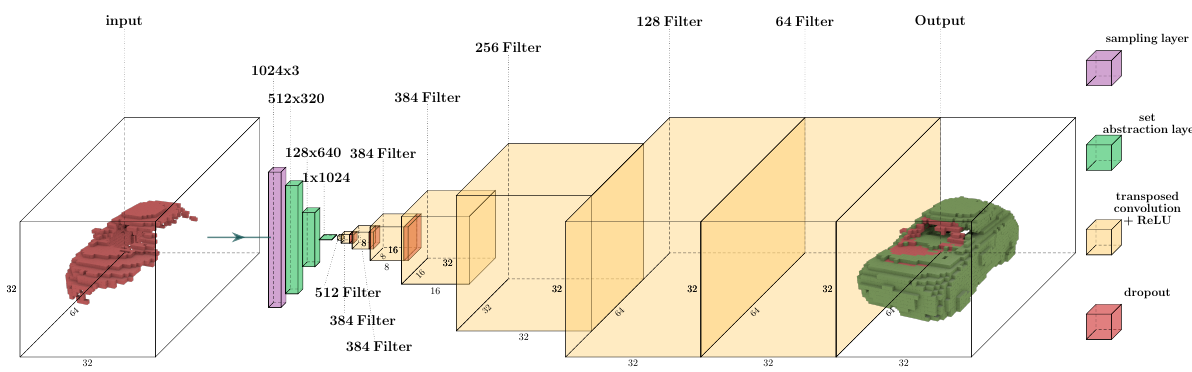
Figure 3. The generator network receives incomplete shapes (red) as input and completes them (green).